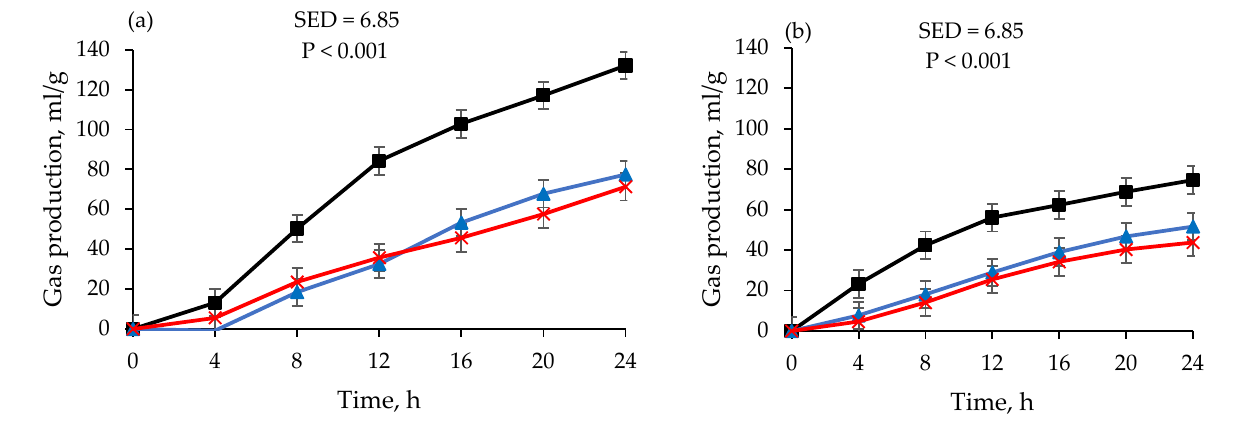
Figure 1. Gas production curves for 24 h incubation of feedstuffs (( a ) wheat grain and ( b ) lucerne hay) at 39 °C using fresh rumen fl uid on day 1 ( ) and rumen fl uid snap-frozen using liquid nitrogen and stored at − 80 °C ( − 80 °C) for 14 days ( ) and 30 days ( ) at varying incubation times. Data at day 1 are for fresh RF. Data are least-square means of gas production after converting gas pressure into gas volume using Avogadro’s law. Table 3. The effects of feedstuffs (wheat grain vs. lucerne hay) and rumen fluid storage conditions (fresh rumen fluid vs. rumen fluid mixed with 5% DMSO and stored at − 20 ◦ C) across storage days incubations using the RF preserved at D − 20 °C were lower ( p < 0.001) compared with the 1, 14, 30, and 180 on fermentation parameters 1